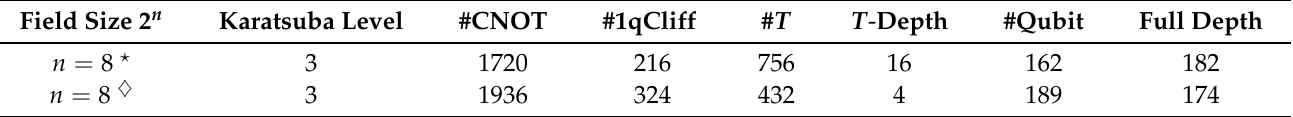
Table 6. Quantum resources needed for inversion of F 2 8 / ( x 8 + x 4 + x 3 + x + 1 ) . Field Size 2